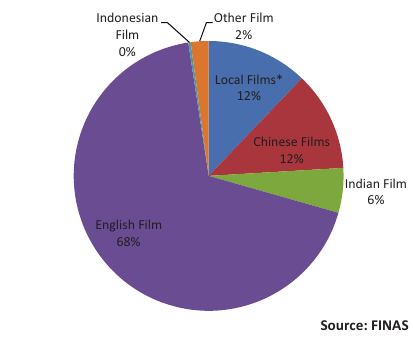
Figure 2. Market share of local movies versus foreign movies (2006–2016) (source: FINAS (2019b) (figures were compiled from information from the FINAS (2016)